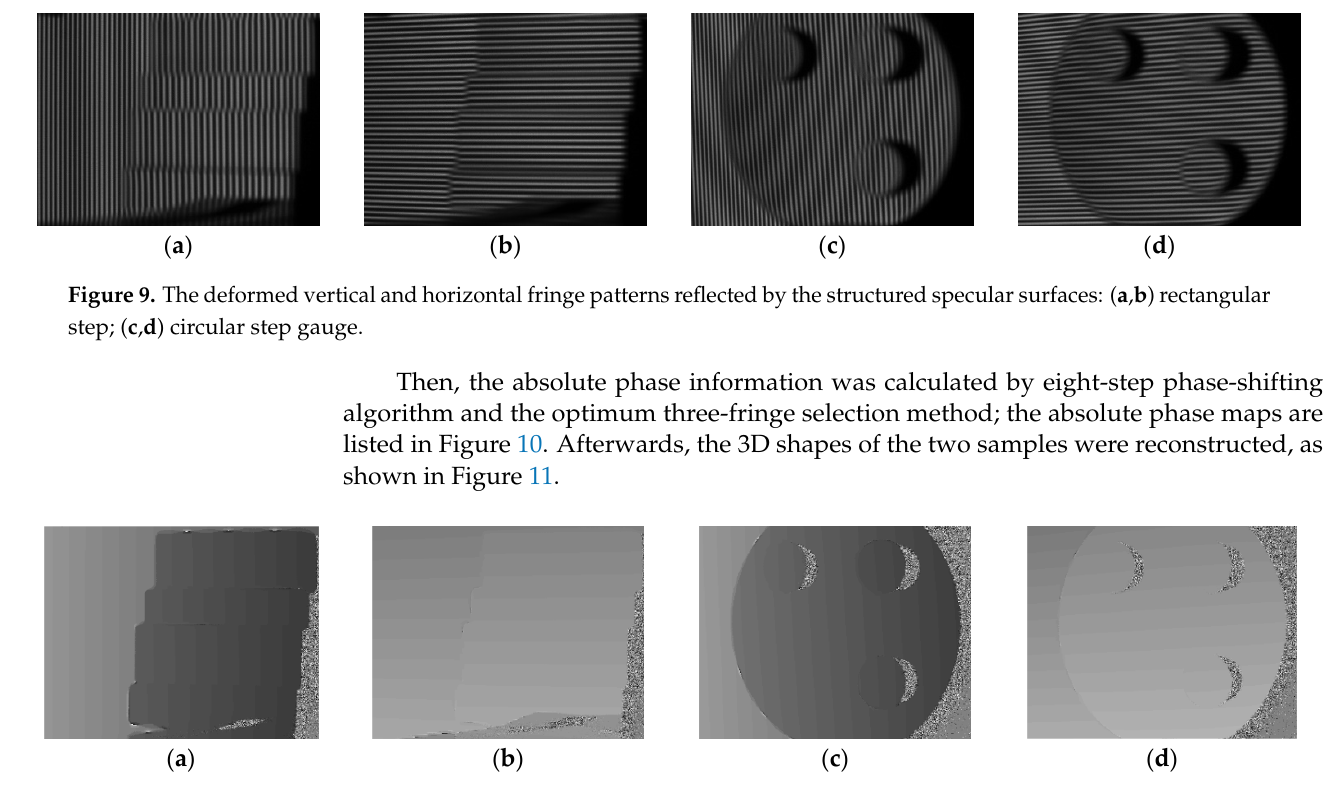
( b ) Figure 11. The 3D shape of two samples: ( a ) rectangular step; ( b ) circular step gauge. Limited by the manufacturing accuracy, the surfaces of the circular step gauge in Figure 11b are not parallel, but it can be seen from its reconstruction results that the pro- posed method can achieve the measurement of structured specular surfaces. The rectan- gular gauge in Figure 11a has four parallel planes, so the relative height between adjacent steps can be used to evaluate the measurement accuracy of discontinuous surfaces. By fitting the 3D data of four separate surfaces obtained by the proposed method into ideal planes, the height differences between every two adjacent surfaces can be calculated, as shown in the third column of Table 2. For comparison, the corresponding height data were also measured by CMM (within a measuring accuracy of 2 µm). The measurement of each isolated surface of the sample is realized by measuring the depth information of 8 to 10